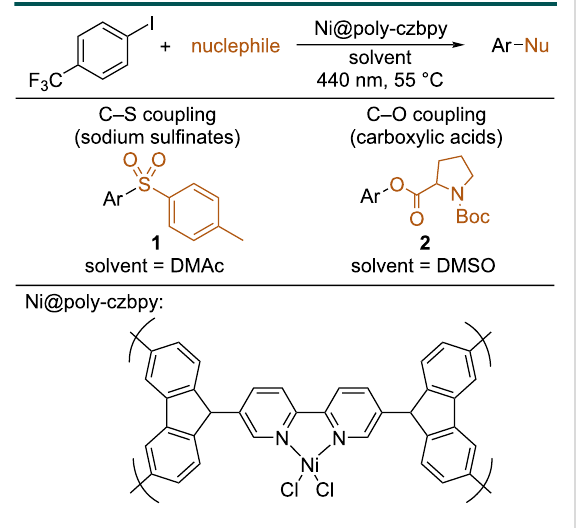
Figure 2: Light-mediated carbon–heteroatom cross-couplings. The yields reported are the NMR yields obtained in flow with the optimized conditions described later. DMAc = dimethylacetamide, DMSO = dimethyl sulfoxide.